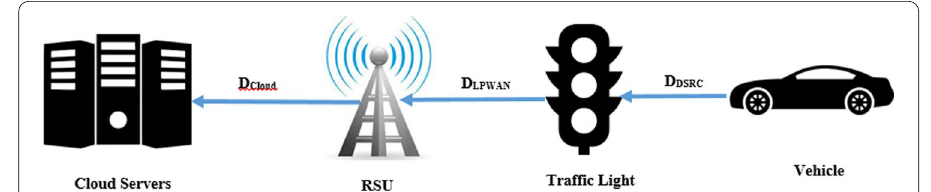
Fig. 2 End-to-End latency from vehicle to